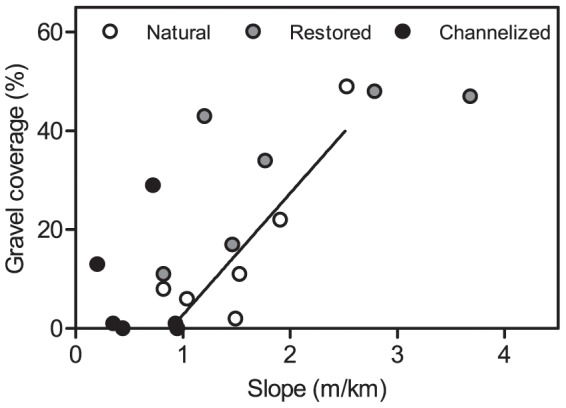
Relationship between stream bed slope and gravel coverage in the 3 stream types.The solid regression line describes the relationship in natural streams.